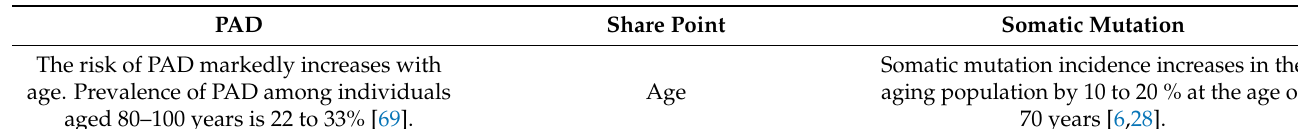
Diabetic patients have two to four-fold increased risk of developing PAD, CAD, and ischemic stroke